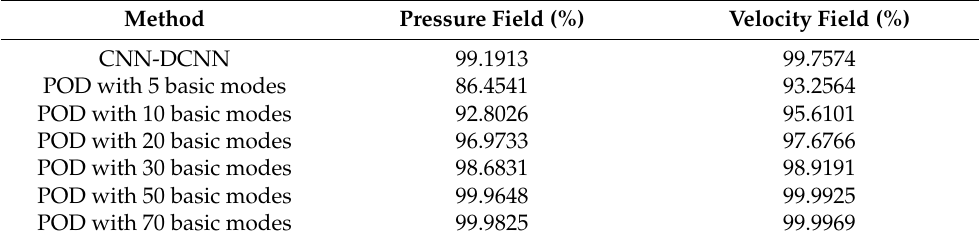
Figure 15. POD/CNN-DCNN comparison of the reconstructed physical field (case 3: NACA6212, AOA = 3°, Re = 7 × 10 6 ): ( a ) pressure field; ( b ) velocity field. Table 8. CNN-DCNN/POD comparison of accuracy for case